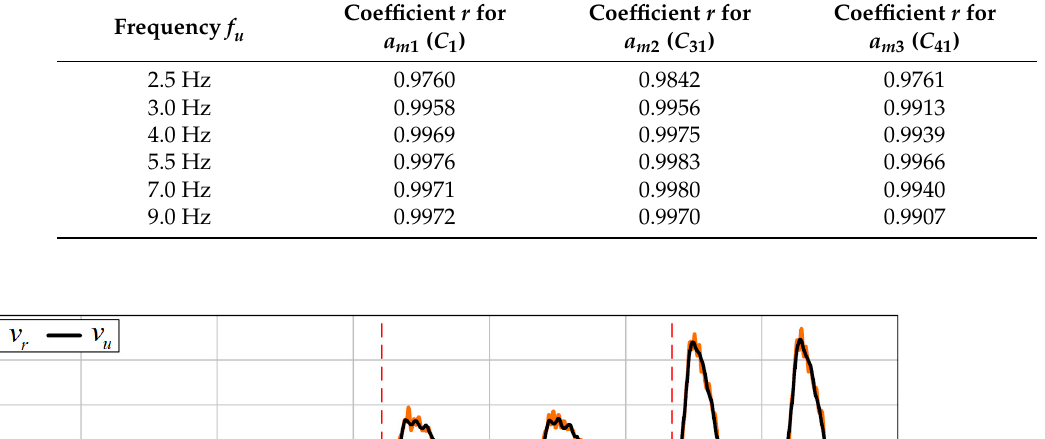
Table 2. Values of linear correlation coefficient r .